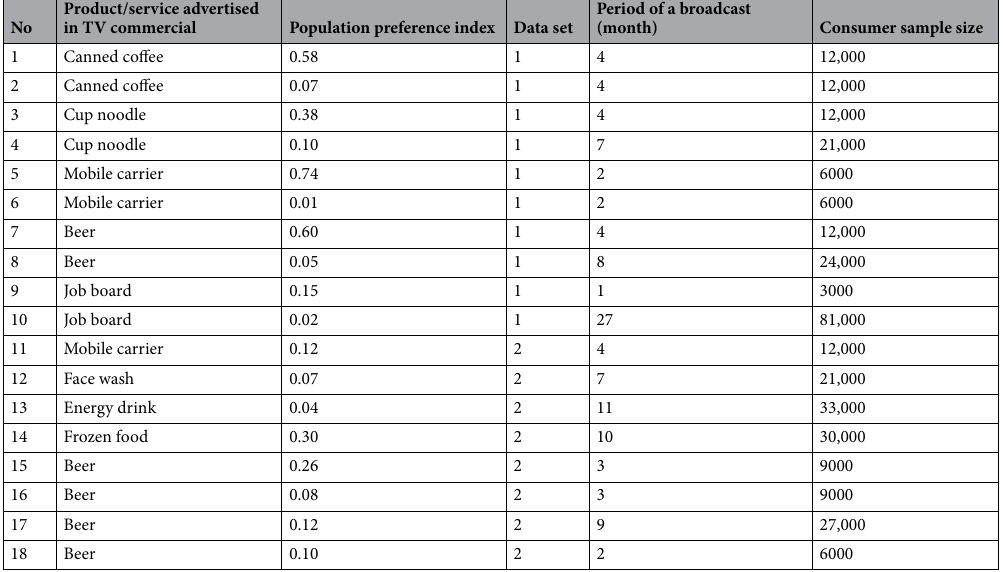
Table 1. TV commercials and population preference